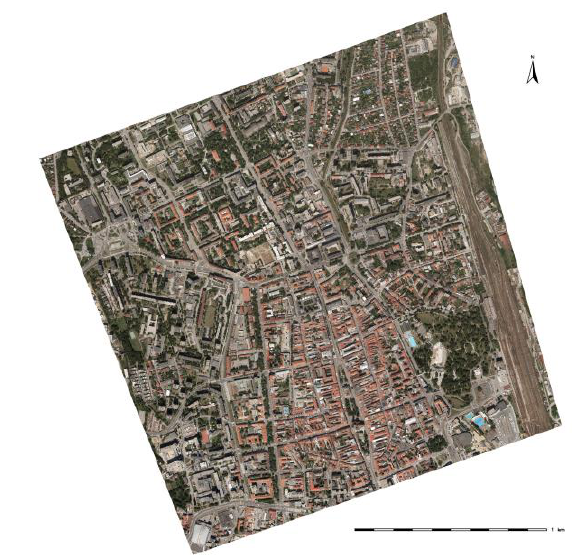
Figure 1 . Orthophotograph of the study area in the city of Košice.